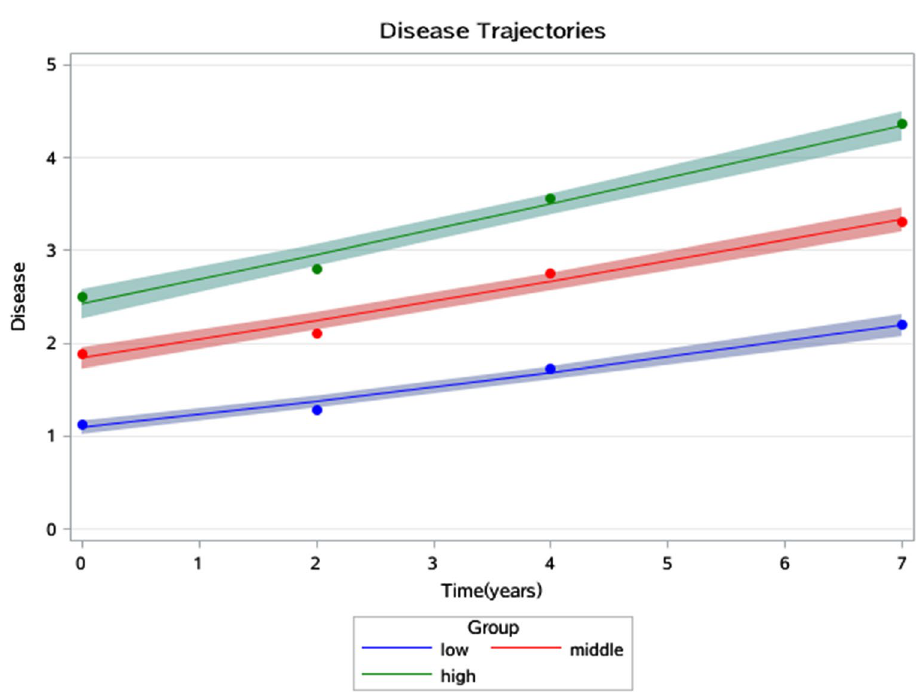
Figure 2. Disease trajectories among a sample of older individuals that survived a 7-year period in